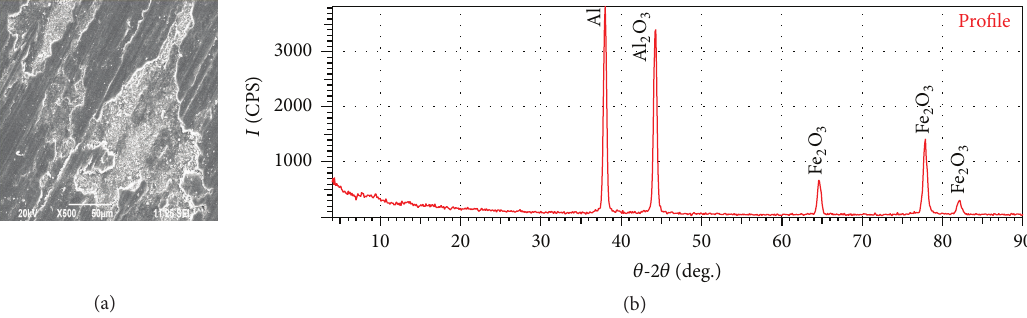
Figure 10: (a) SEM of worn surface of sample-I after running 1000 m at 29.43 N load and 4.71m/s sliding speed. (b) XRD test report of the worn surface of sample-I.